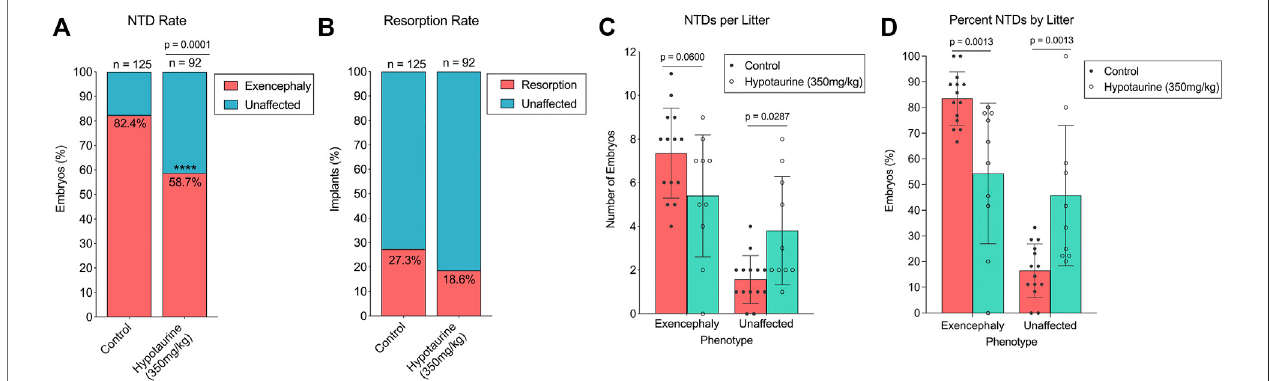
FIGURE 5 | Effect of hypotaurine supplementation on NTD and resorption rates in VPA-treated SWV. (A) Proportion of embryos with exencephaly phenotypes observed in the placebo and hypotaurine (350 mg/kg) groups. (B) Proportion of resorption phenotypes observed in the placebo and hypotaurine (350 mg/kg) groups. (C) Number of NTDs observed per litter in the placebo and hypotaurine (350 mg/kg) groups. (D) Percent NTDs observed per litter in the placebo and hypotaurine (350 mg/kg) groups. *Statistical signi fi cance determined by two-sample proportion tests (A,B) or two-way ANOVA with Š ídák ’ s multiple comparisons (C,D) ( α < .05)